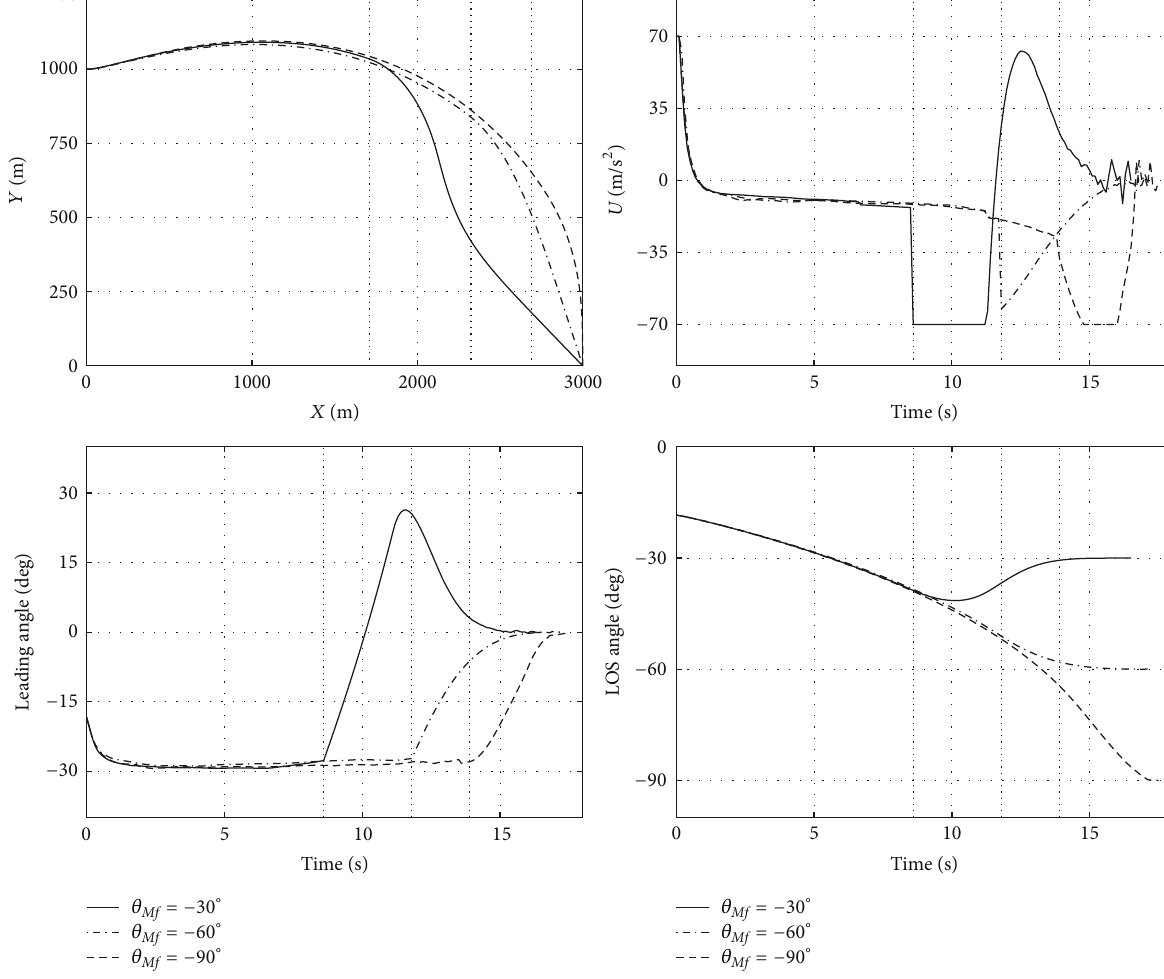
Figure 4: Simulation results comparisons under different impact angle constraints.